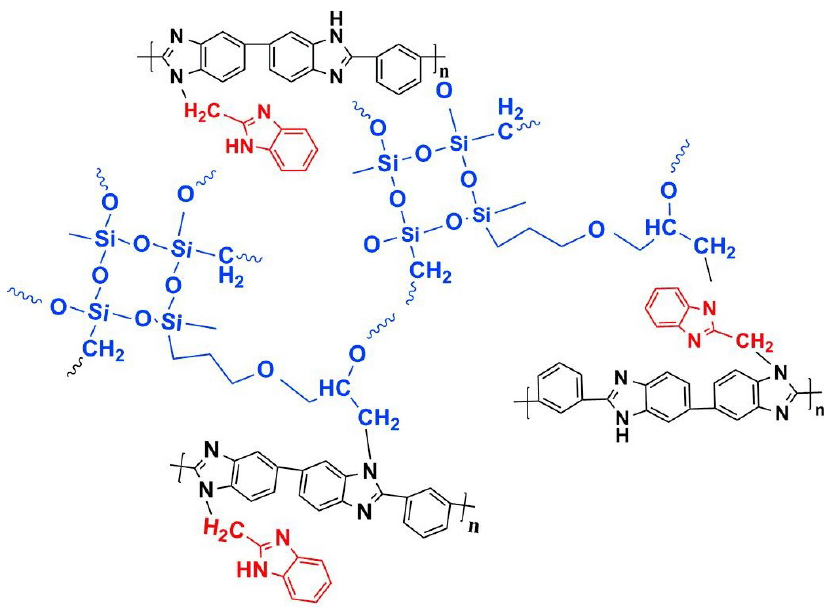
Figure 5. The cross-linked structure of CPBIm-X (taken from Ref. [69]).